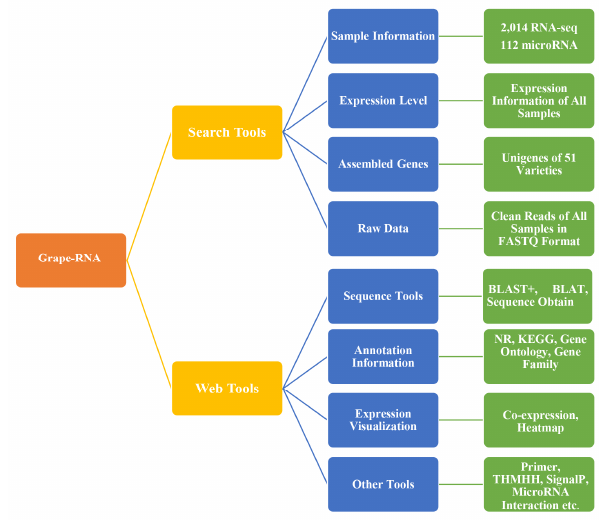
Figure 3. The detail information and architecture structure of Grape-RNA.